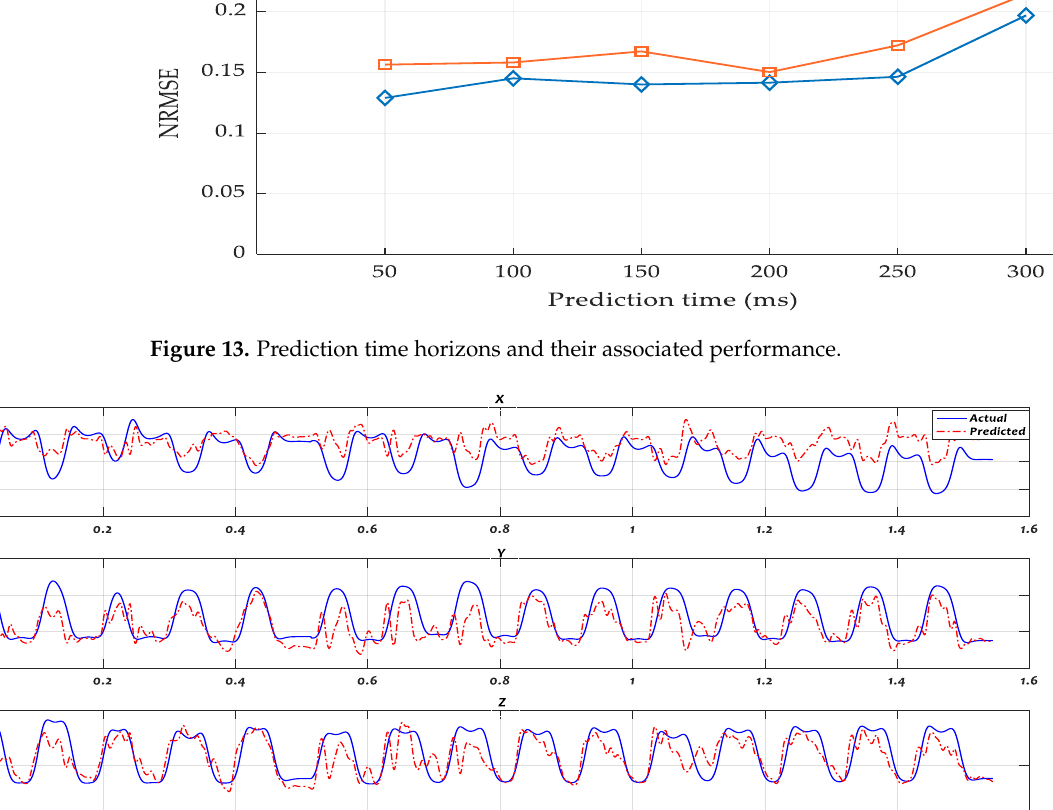
Figure 14. The trajectory predicted by recurrent fuzzy neural network (RFNN) against the actual trajectory of Task 1 in 3-D.